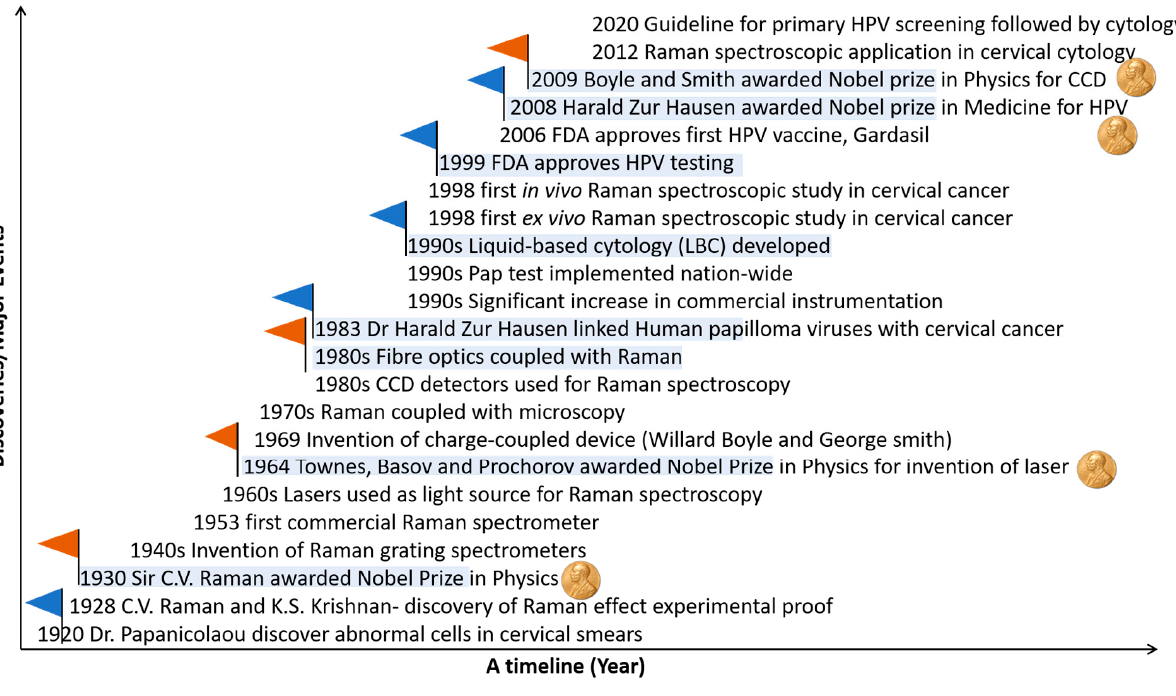
Figure 1. Major events in cervical cancer screening and Raman spectroscopy (blue colour—-flag event in Cervical cancer screening; orange colour—-flag events in technological advancement in Raman spectroscopy).